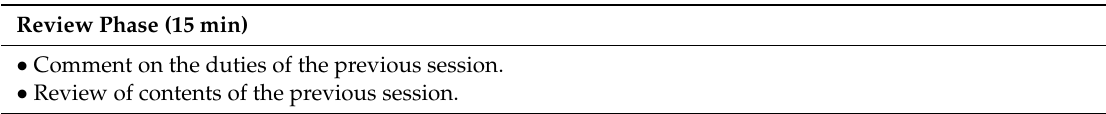
Table 1. Outline of active group sessions in NAT-FM